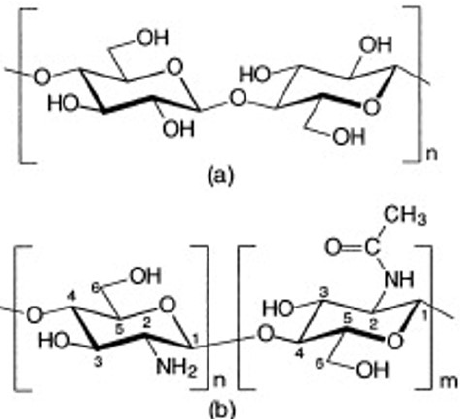
Figure 3. Chemical structure of cellulose ( a ), chitin and chitosan ( b )—chitin consists mainly of monomers “m” (N-acetyl form), while chitosan, according to the degree of deacetylation, consists mainly of monomers “n” (amine form) [15]. Review of Chitosan and Its Derivatives as Antimicrobial Agents and Their Uses as Textile Chemicals. Lim, Sang-Hoon, Hudson, Samuel M., Journal of Macromolecular Science , Part C, 6 January 2003; reprinted with permission of the publisher Taylor & Francis.